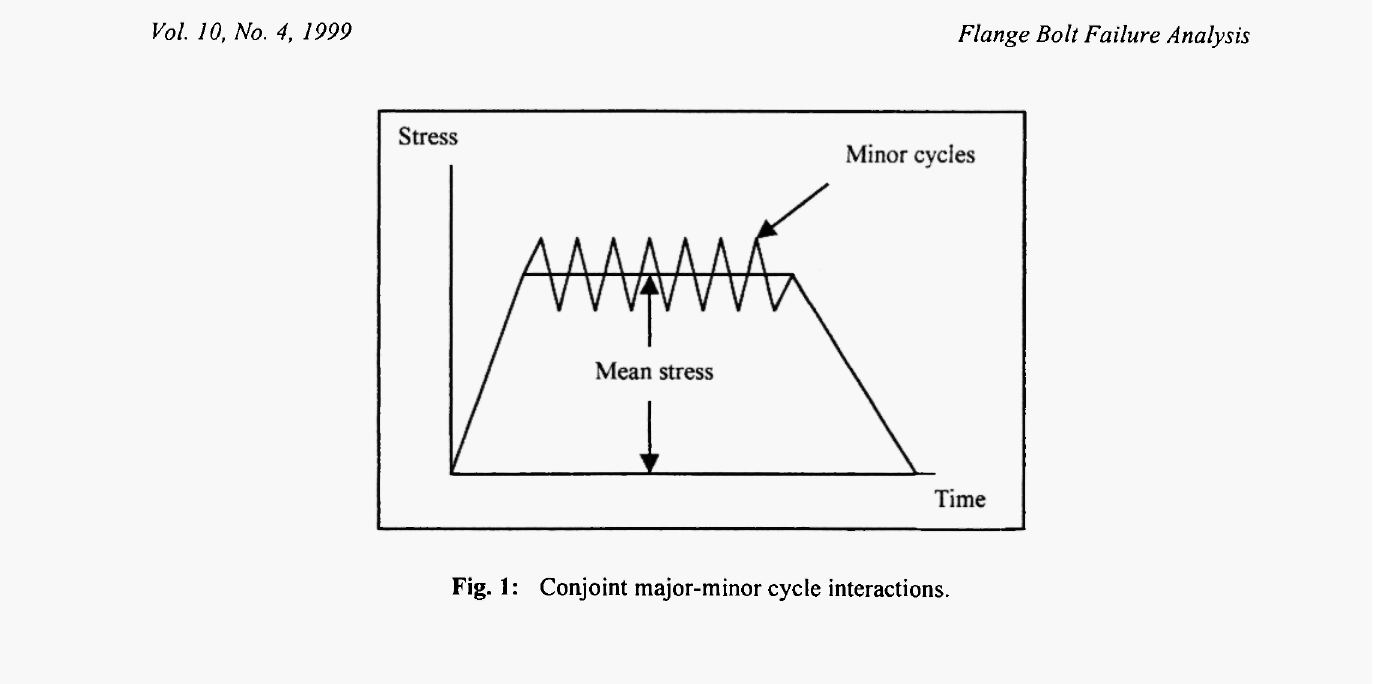
Fig. 1: Conjoint major-minor cycle